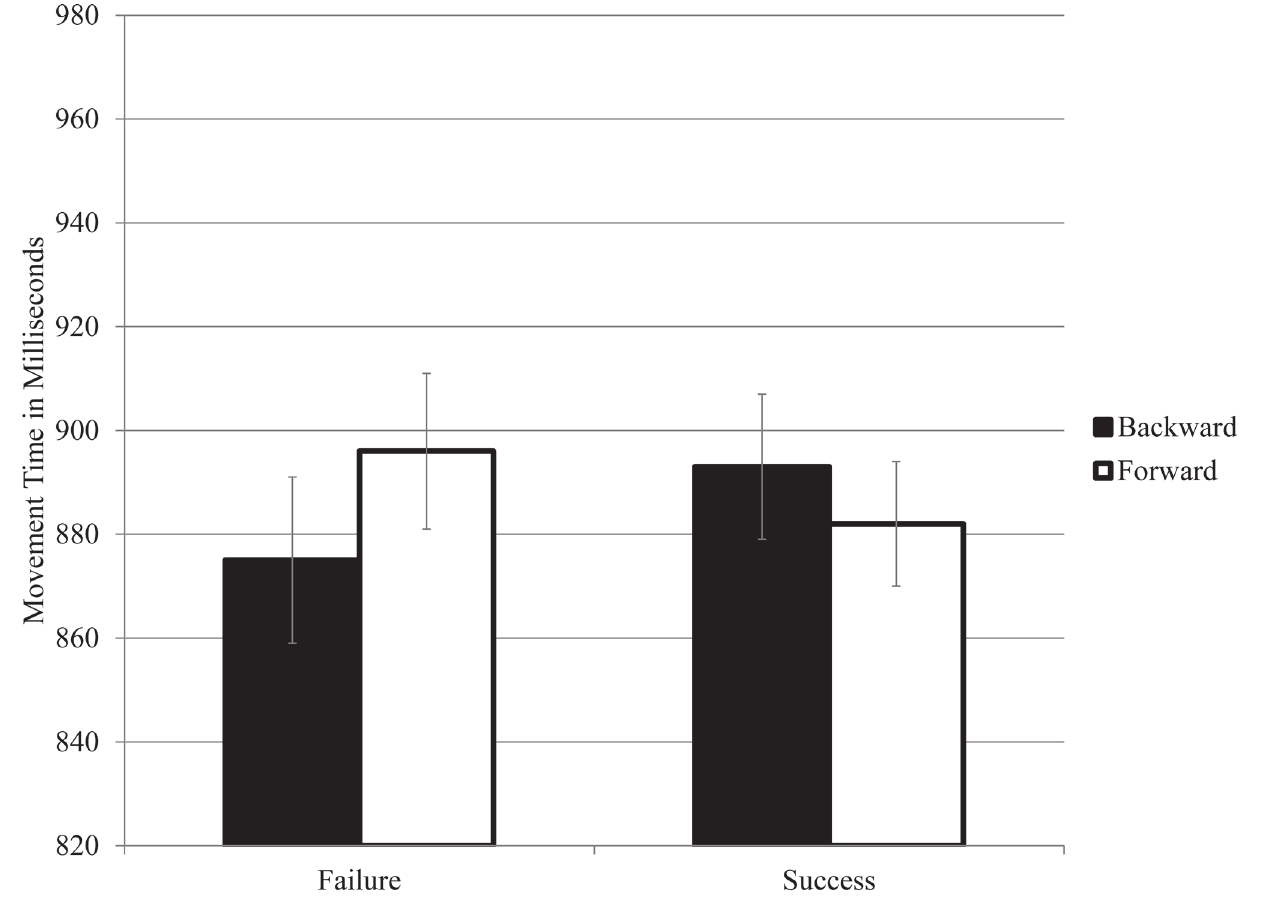
Fig 2. Movement Times with Standard Errors as a Function of Prime Category (Success versus Failure) and Movement Direction (Forward versus Backward), Experiment 2.